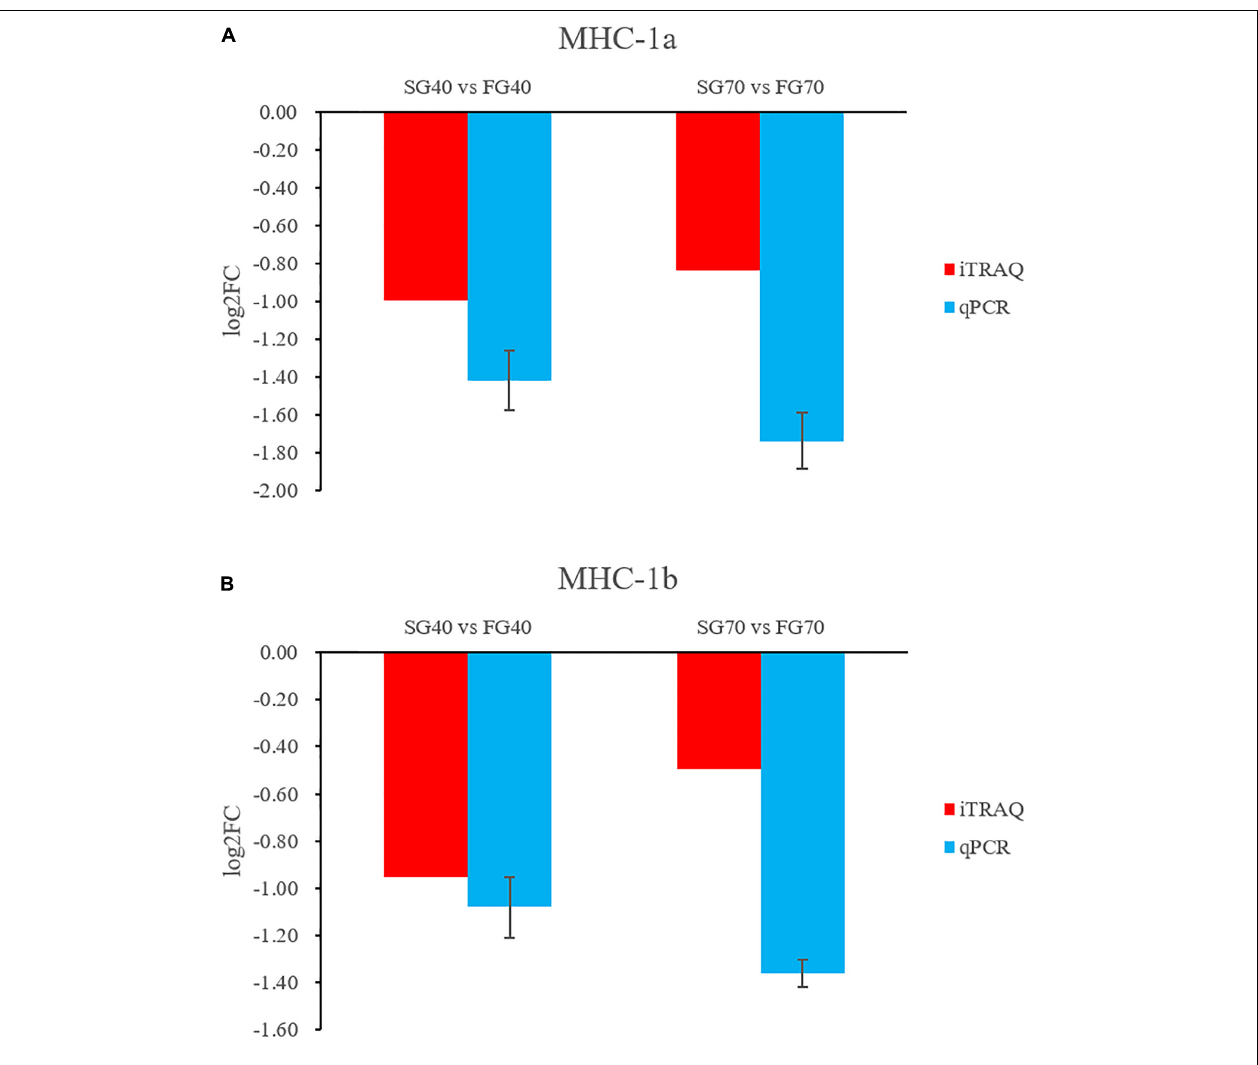
FIGURE 7 | Verification of MHC-1a and MHC-1b by